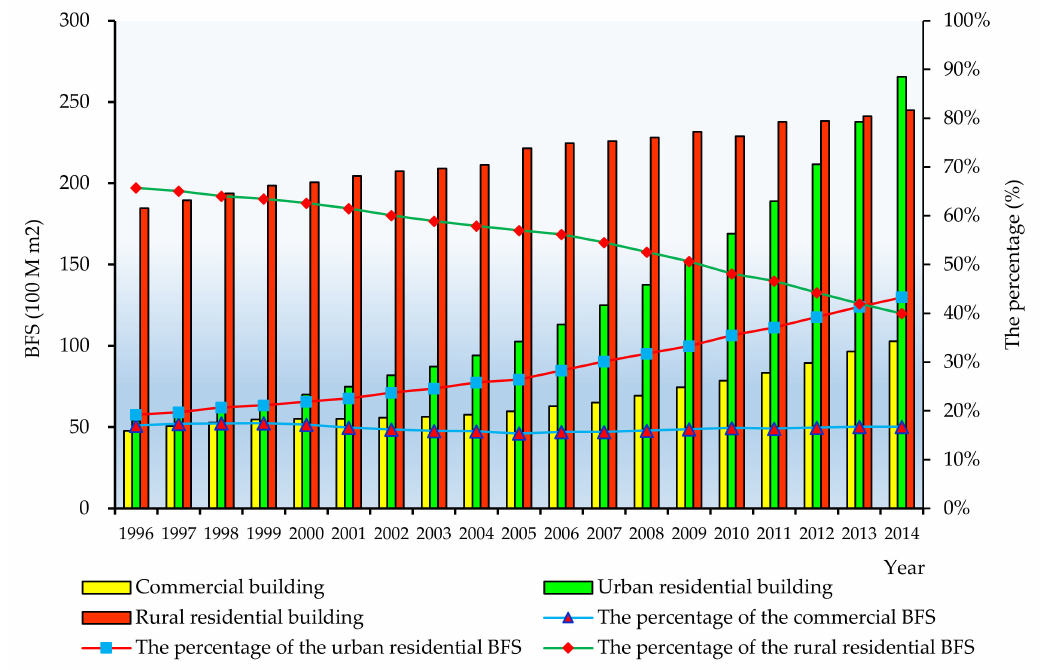
Figure 5. The composition of the building floor space